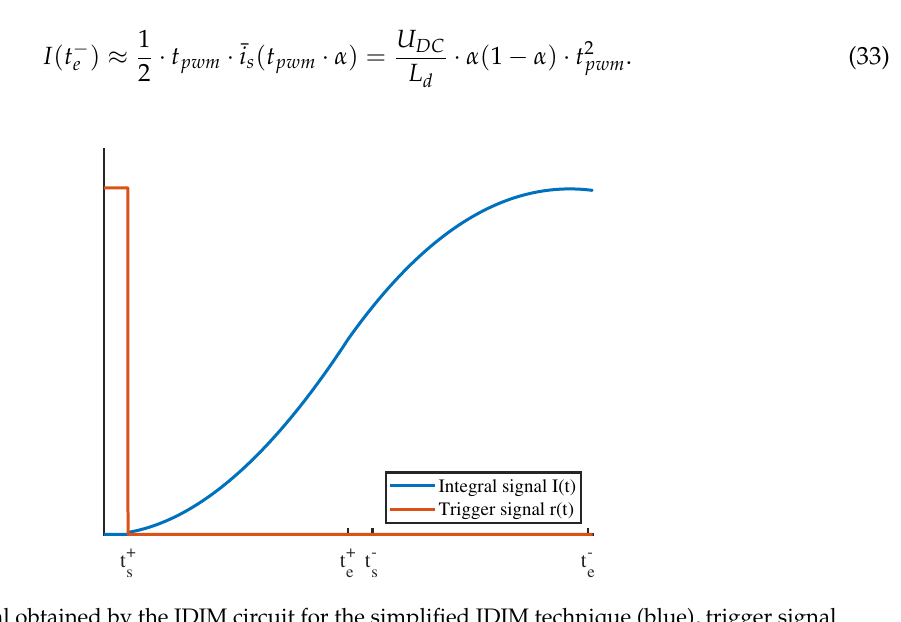
Figure 8. Integral obtained by the IDIM circuit for the simplified IDIM technique (blue), trigger signal r ( t ) (red) as well as time instants, exemplary shown for α =